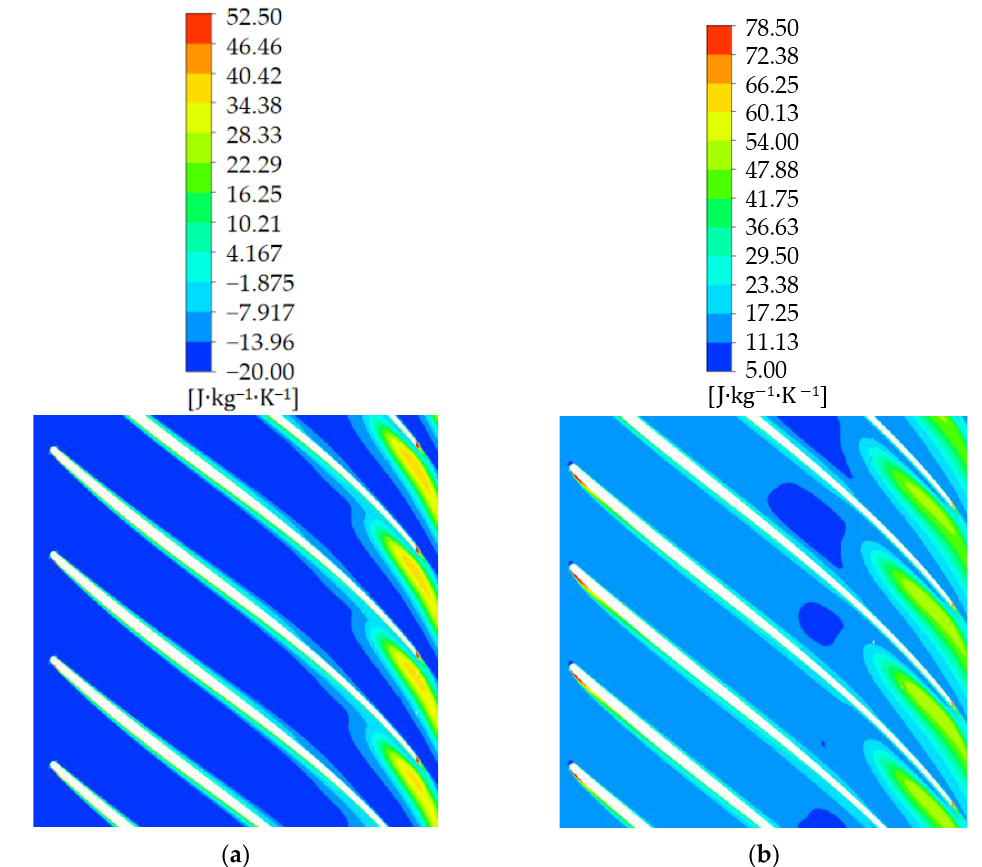
Figure 10. Static entropy contours of 50% heights of impellers. ( a ) First stage. ( b ) Second stage.